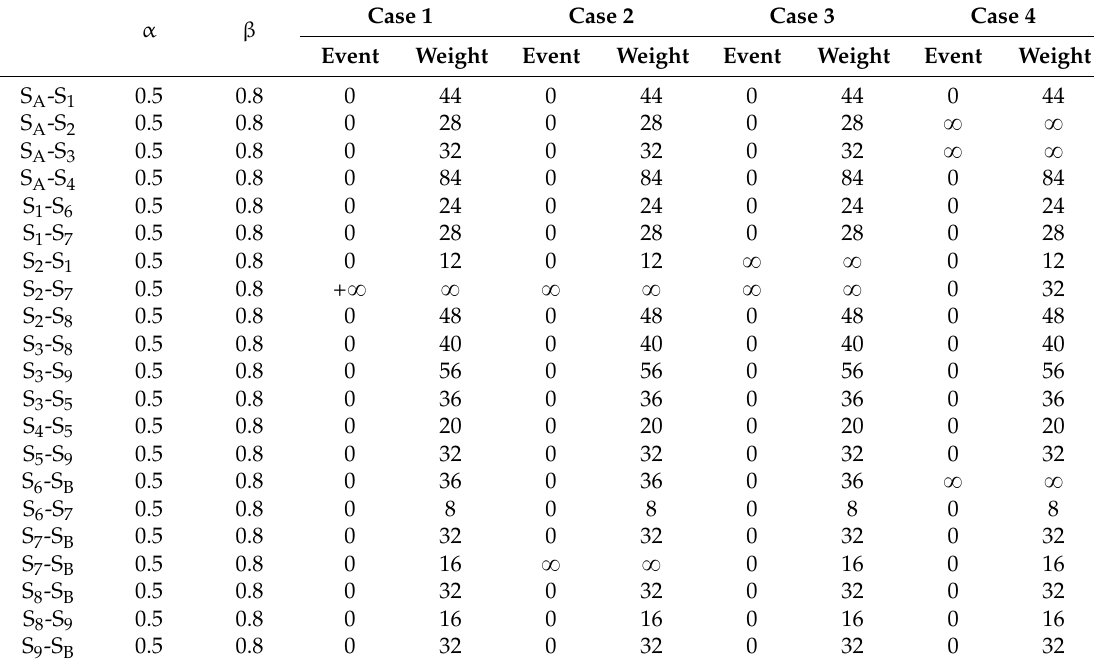
Table 1. MCS weights for routing.